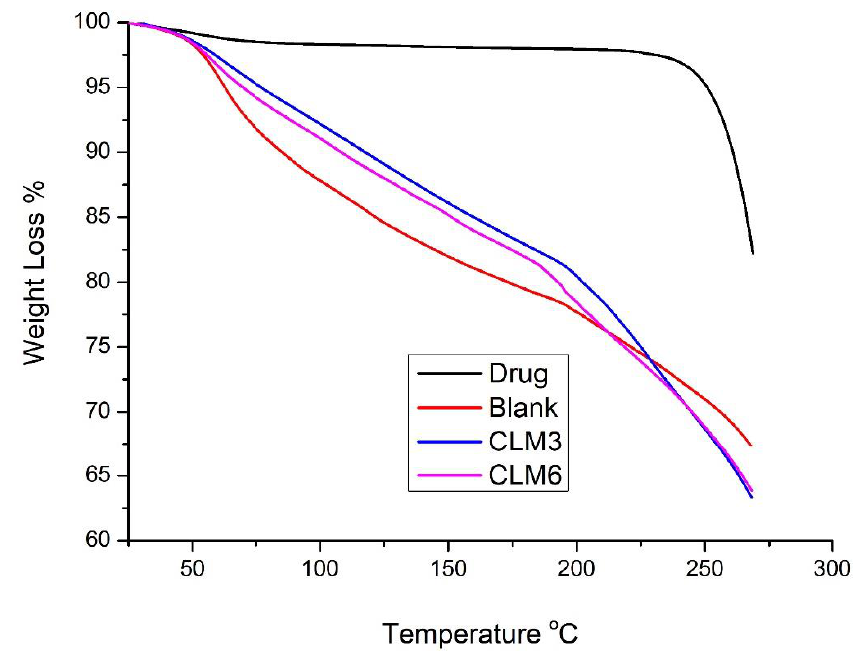
Figure 9. TGA graph of clarithromycin, blank, CLM3, and CLM6